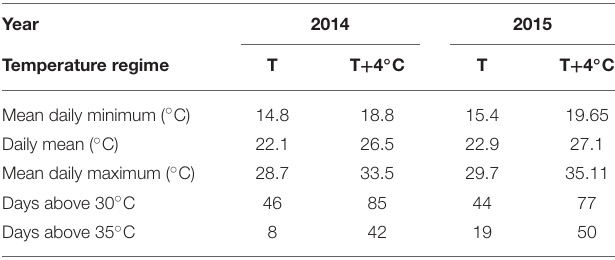
TABLE 1 | Temperature recorded in the temperature gradient greenhouse experiments with ‘Red Tempranillo’ and ‘White Tempranillo’